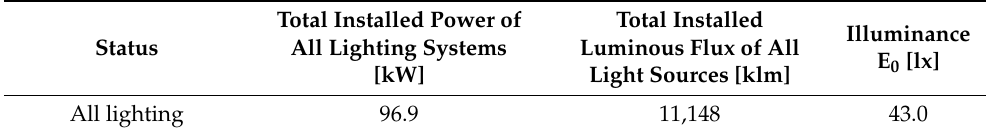
Table 4. Key parameters of the model of new lighting installation in TR Slavˇetice after refurbishment. Total Installed Power of Total Installed Illuminance Status All Lighting Systems Luminous Flux of All E 0 [lx] [kW] Light Sources [klm] All lighting 96.9 11,148